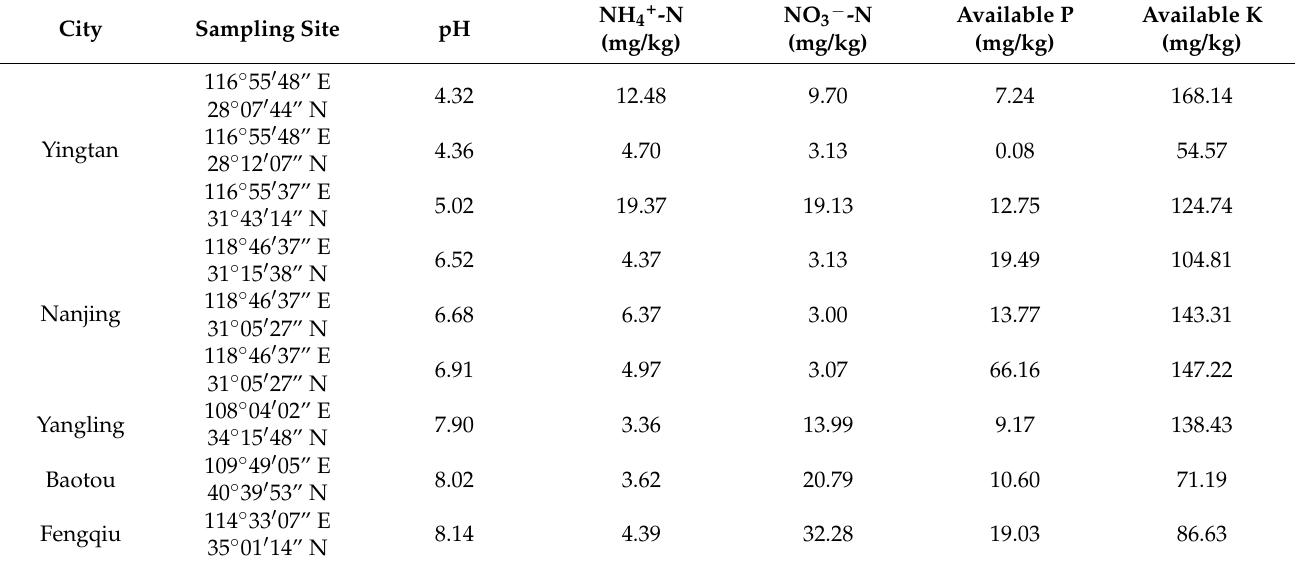
Table 1. Basic information on experimental